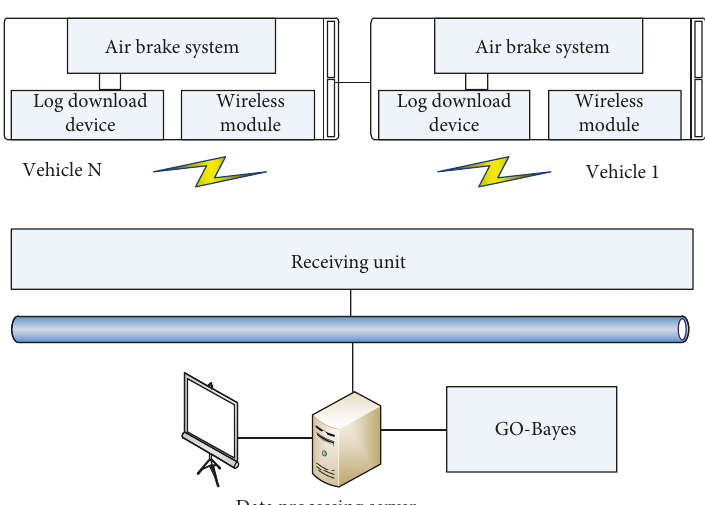
Figure 12: Big data system